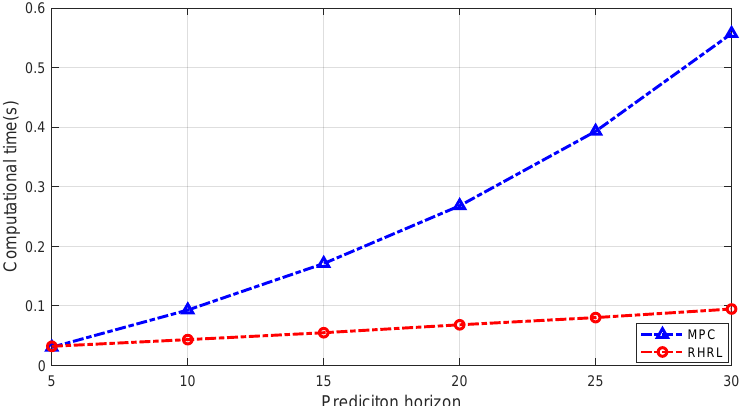
Figure 10. Computational time at different prediction